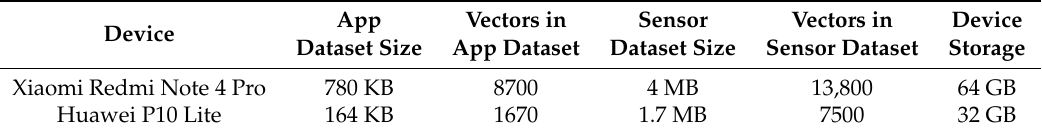
Table 9. Storage consumption of our adaptive and continuous authentication system.